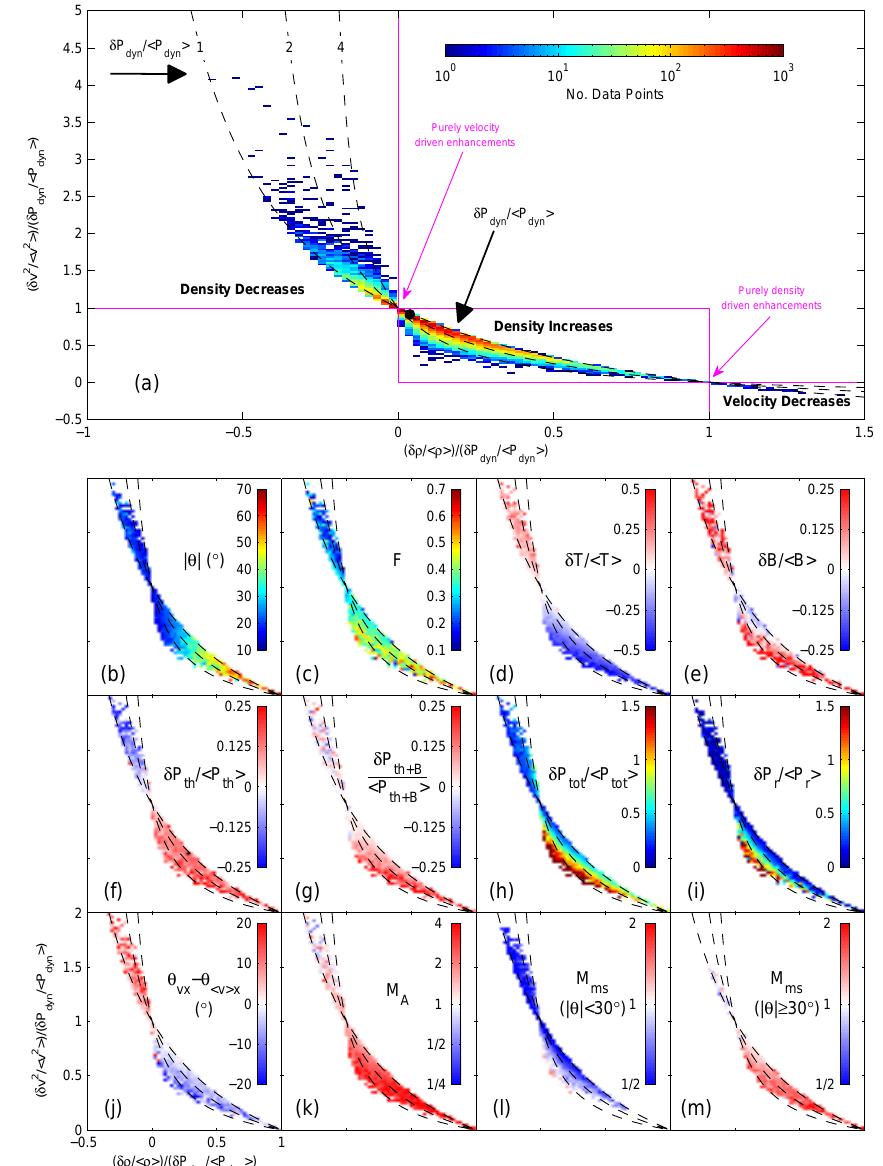
Fig. 3. (a) Distribution of dynamic pressure enhancements in the density–velocity term parameter space where the colour scale is the number of data points in each bin. The black dot marks the maximum of the distribution. Three different regions are indicated by the magenta lines. Contours of δP dyn / (cid:10) P dyn (cid:11) are given by the black dashed lines, with the black arrows specifying the direction of increasing δP dyn / (cid:10) P dyn (cid:11) in the different regions. (b) – (m) Means in each parameter space bin of the (b) aberrated solar zenith angle; (c) fractional magnetopause distance; (d) fractional temperature change; (e) fractional magnetic field strength change; (f) fractional ion thermal pressure change; (g) fractional change in ion thermal and magnetic pressures; (h) fractional total pressure change; (i) fractional radially inward pressure change; (j) change in the velocity cone angle; (k) Alfv´enic Mach number; and magnetosonic mach numbers for both the (l) subsolar and (m) flank